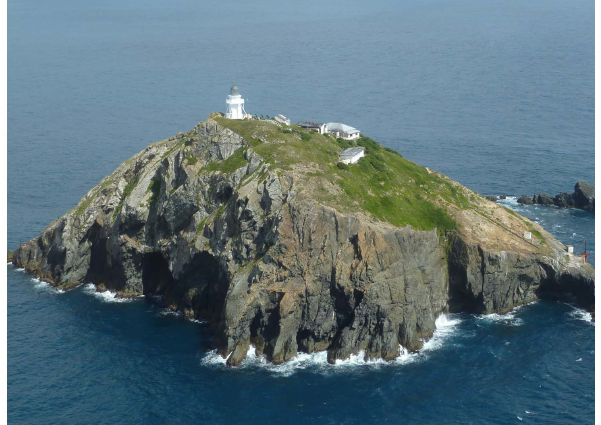
Figure 1. North Brother Island in the Cook Strait of Zealand. A rocky, 4 hectare wildlife sanctuary and lighthouse station that rises to 66 m above sea level. It is the southernmost island supporting a naturally occurring population of tuatara and has a rugged topography and limited vegetation. The vegetated slop is north facing and is the location where nesting occurs. Printed with permission from the photographer, J. Monks.